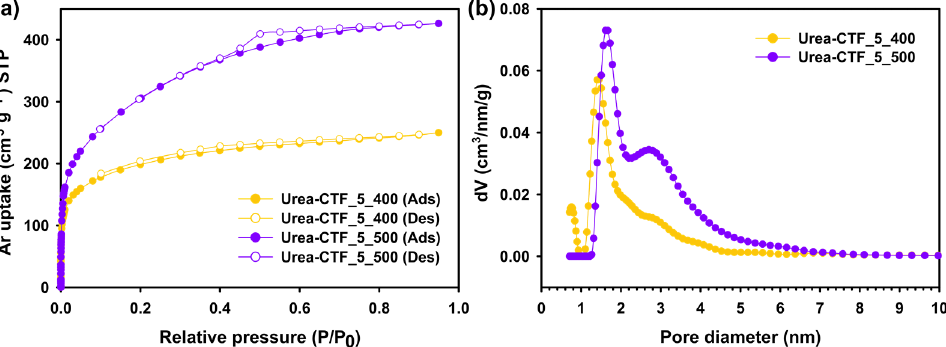
Figure 1. ( a ) Argon sorption isotherms measured at 87 K and ( b ) the pore-size distribution of the urea-CTFs based on quenched solid density functional theory (QSDFT) cylindrical pores.